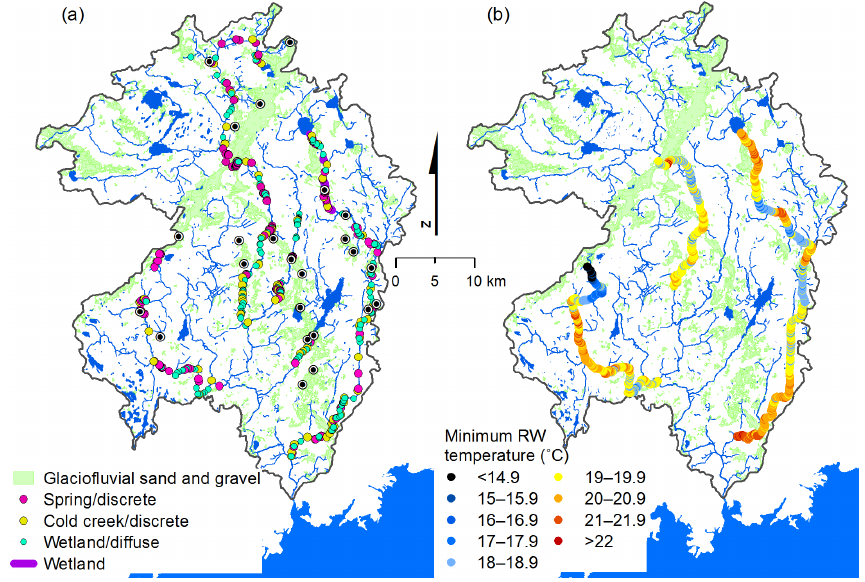
Figure 4. (a) Thermal anomalies identified in the AIR surveys in 2010 and 2011. (b) The longitudinal profiles of T minr of the rivers Van- taa, Keravanjoki and Lepsämänjoki in 2011. (Basemap Database © National Land Survey of Finland 2010; Quaternary Deposit Database © Geological Survey of Finland 2008; Watershed Database © SYKE